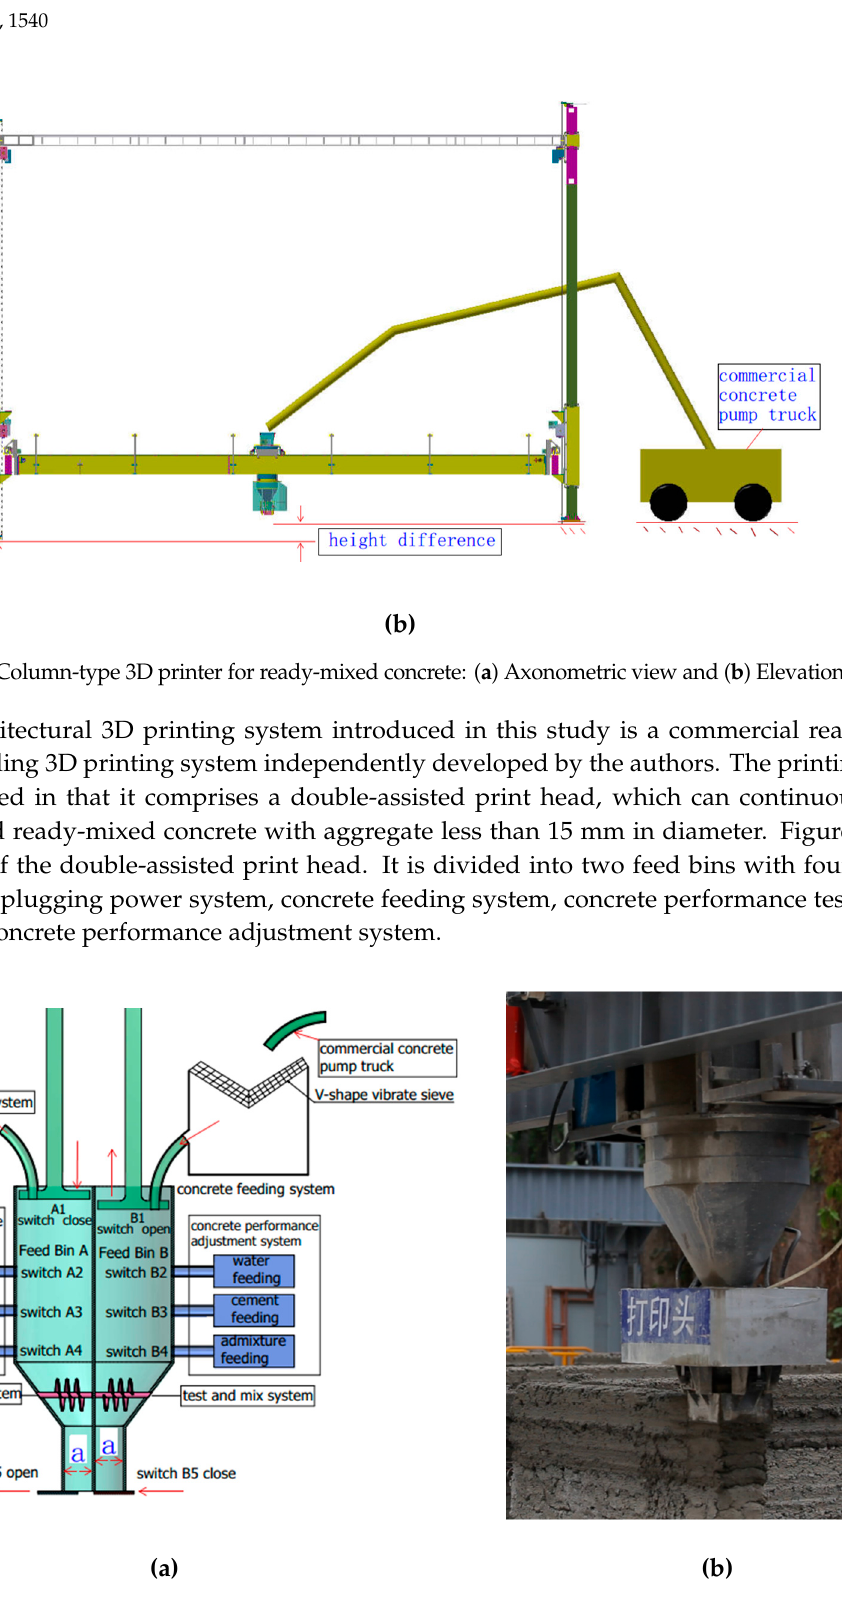
Figure 2. Schematic of double-assisted print head ( a ) Design diagram and ( b ) Print head in the field